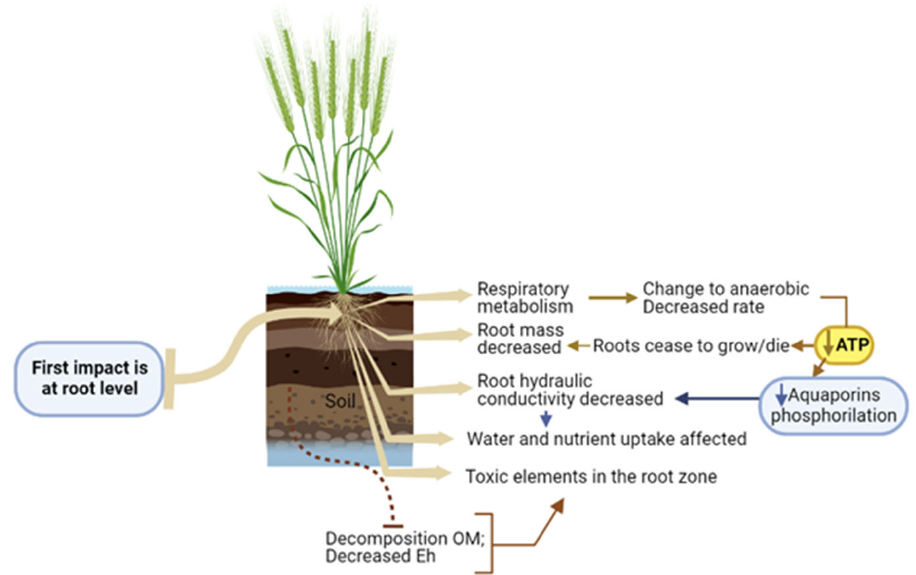
Figure 1. Major effects of waterlogging occurring at root level. Figure elements created using biorender.com (accessed on 15 December 2022).